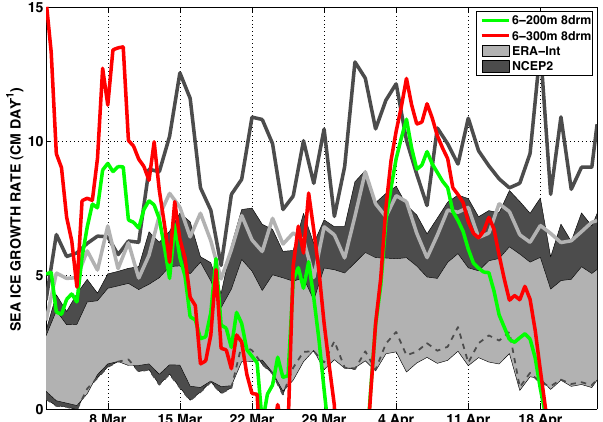
Fig. 12. Comparison of seal-derived (this paper) and satellite- derived (following Tamura et al. (2008), using ERA-Interim and NCEP-2 data) sea ice growth rates. Time series of seal-derived sea ice growth rates (mday − 1 ) are from Fig. 10e (6–200m in green, 6–300m in red). The shaded areas represent one standard deviation either side of the mean daily satellite-derived sea ice growth rates over the entire Commonwealth Bay polynya area from 1992–2007. Results are shown for NCEP-2 data (dark gray shaded area) and ERA-Interim data (light gray shaded area), respectively. The max- imum daily satellite-derived values are shown as thick lines (again, NCEP-2 is dark gray, ERA-Interim light gray). As in the caption for Fig. 10, the mean sea ice growth estimated from both satellite datasets, over the two sustained periods of sea ice growth from the seal data, i.e., 4–29 March and 3–18 April, between 1992–2007, are 3.3 and 4.3cmday − 1 ,